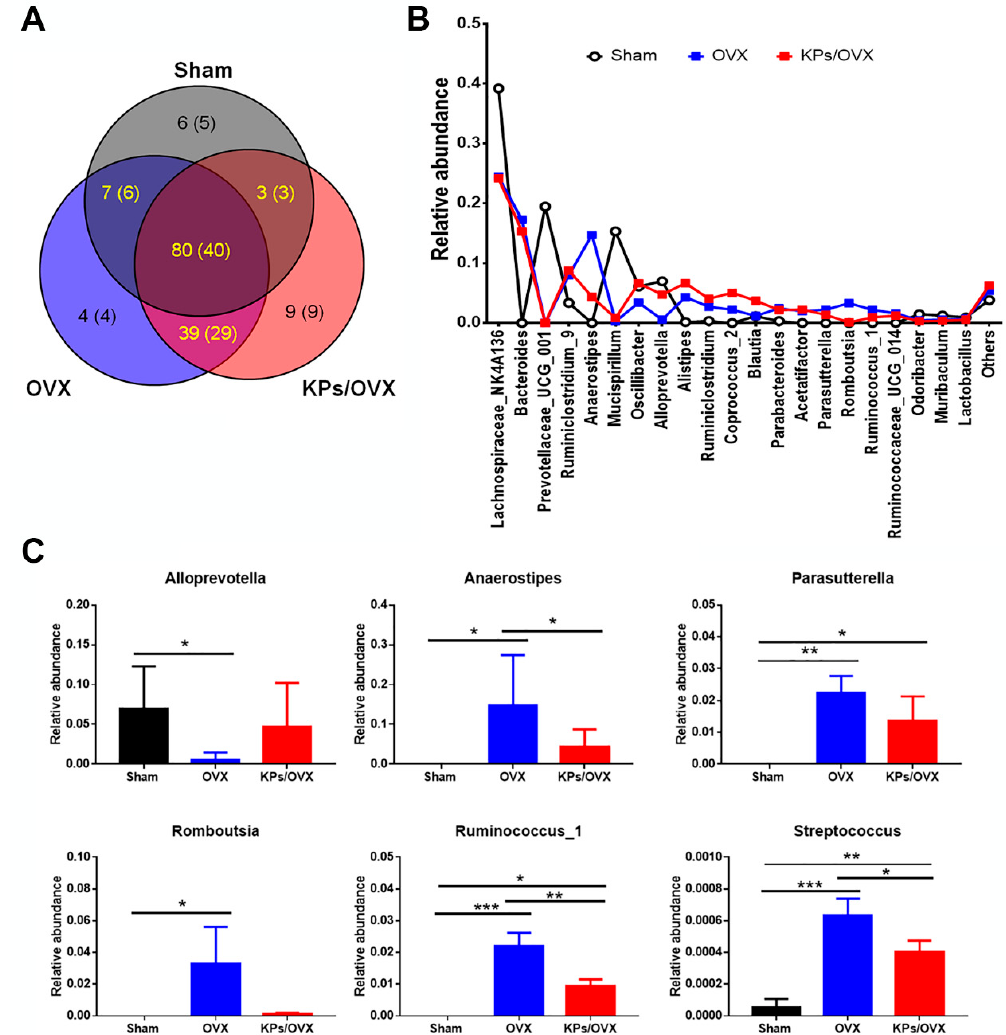
Figure 5. Structural comparison of the gut microbiota at the genus level. ( A ) Venn diagram comparing the observed operational taxonomic units in the gut microbiota of sham, OVX and KPs / OVX mice. ( B ) Major bacterial genera identified in this study. ( C ) Mean relative abundances of the genera Alloprevotella , Anaerostipes , Parasutterella , Romboutsia , Ruminococcus_1 and Streptococcus . Compared with the sham group, these bacterial genera were inhibited or enriched in the OVX group but were reversed in the KPs / OVX group. The data are presented as means ± standard deviation (SD) ( n = 3). Statistical analysis was performed by one-way ANOVA and Tukey’s post hoc test. Statistical significances are indicated by asterisks (*, p < 0.05; **, p < 0.01 and ***, p < 0.001).